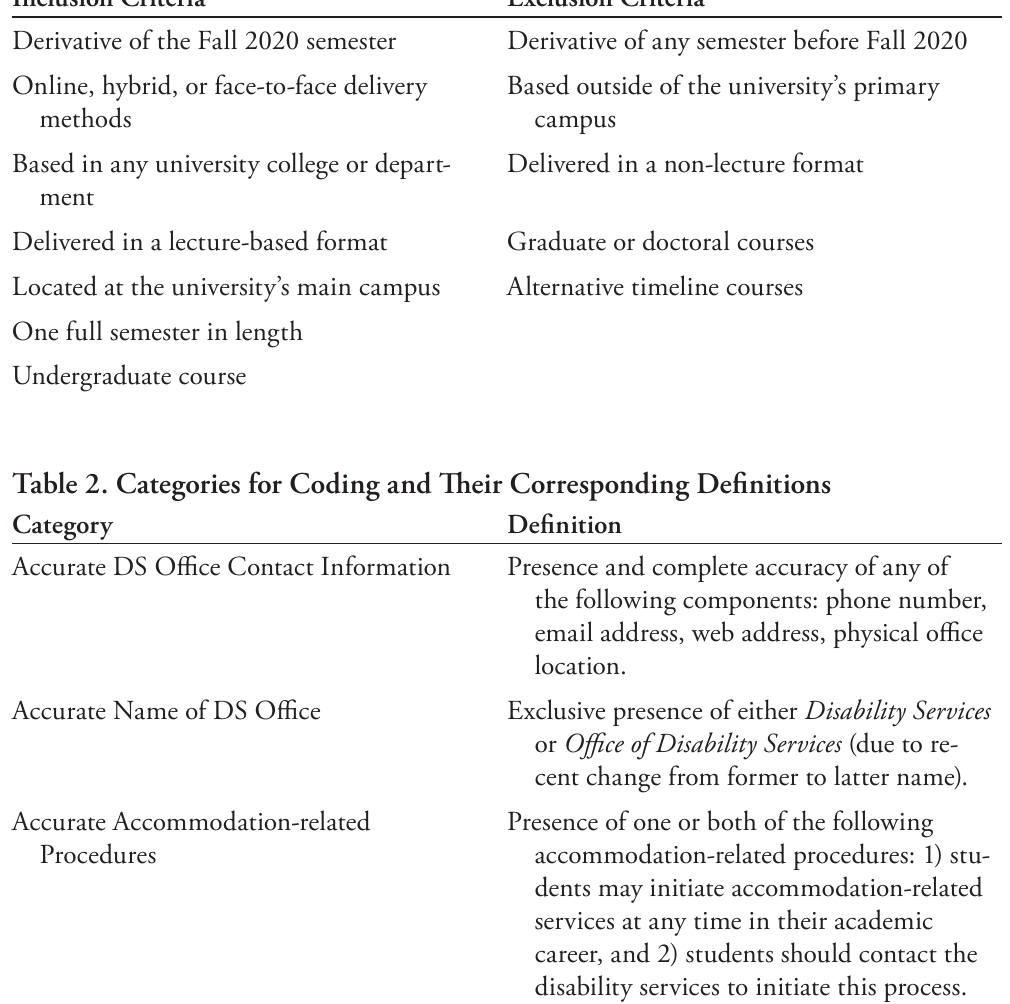
Table 1. Inclusion and Exclusion Criteria for Syllabi